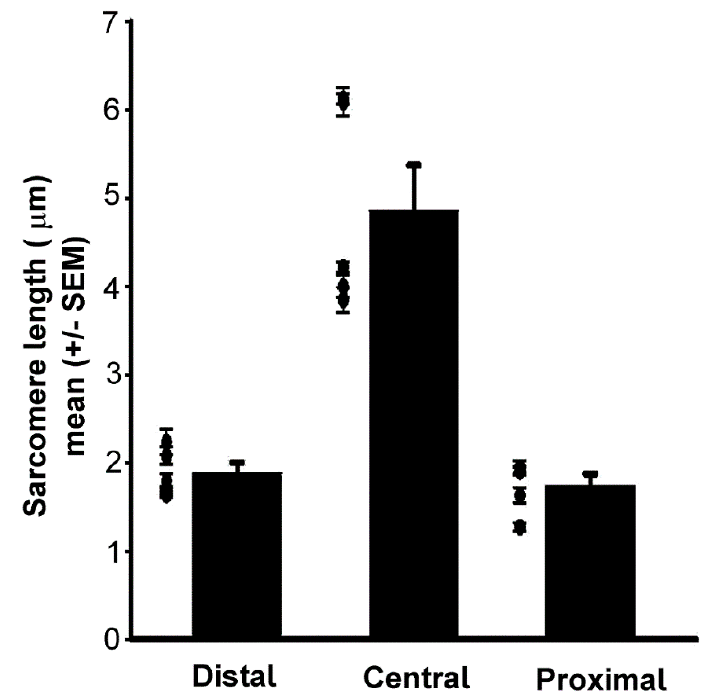
Figure 10. Regional differences in sarcomere lengths: Each dot represents the average measurement in each of the 5 preparations. The bar represents the average of those preparations ( +/ − SEM). The sarcomeres in the central region are larger than those in the proximal and distal. Significant differences for the distal and proximal compared to the central but not between distal and proximal (Holm–Sidak multiple comparison, p < 0.05).